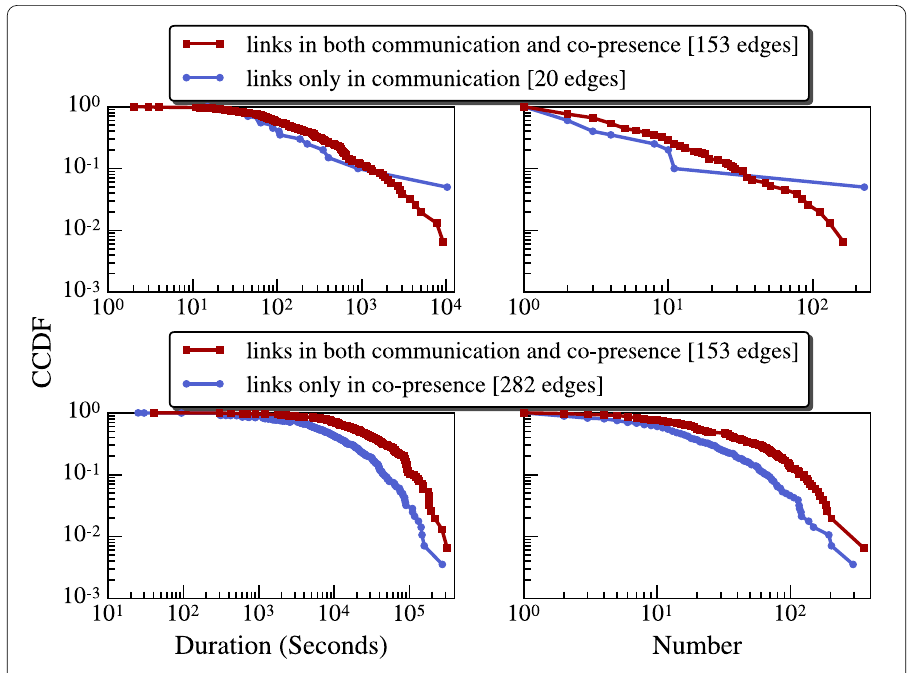
Figure 5 CCDF of weights of links common to communication and co-presence networks, compared to the CCDF of weights of links present only in one of these networks. Top plots: CCDF of the weights in the communication network. Bottom plots: CCDF of the weights in the co-presence network